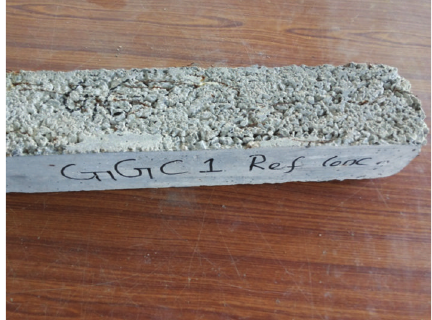
Figure 10: Plain concrete specimens exposed to sodium chloride solution